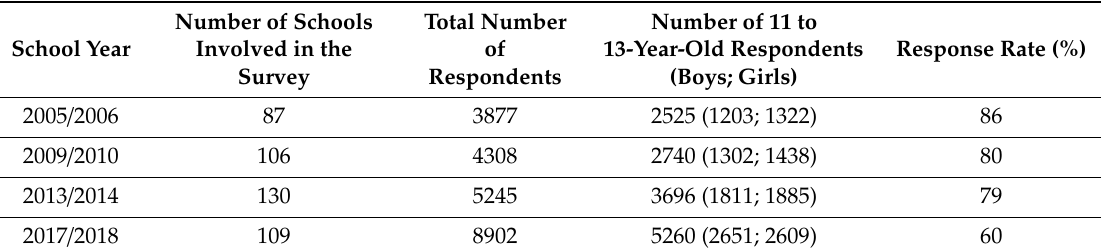
Table 1. Characteristics of the Health Behaviour in School-Aged Children (HBSC) survey